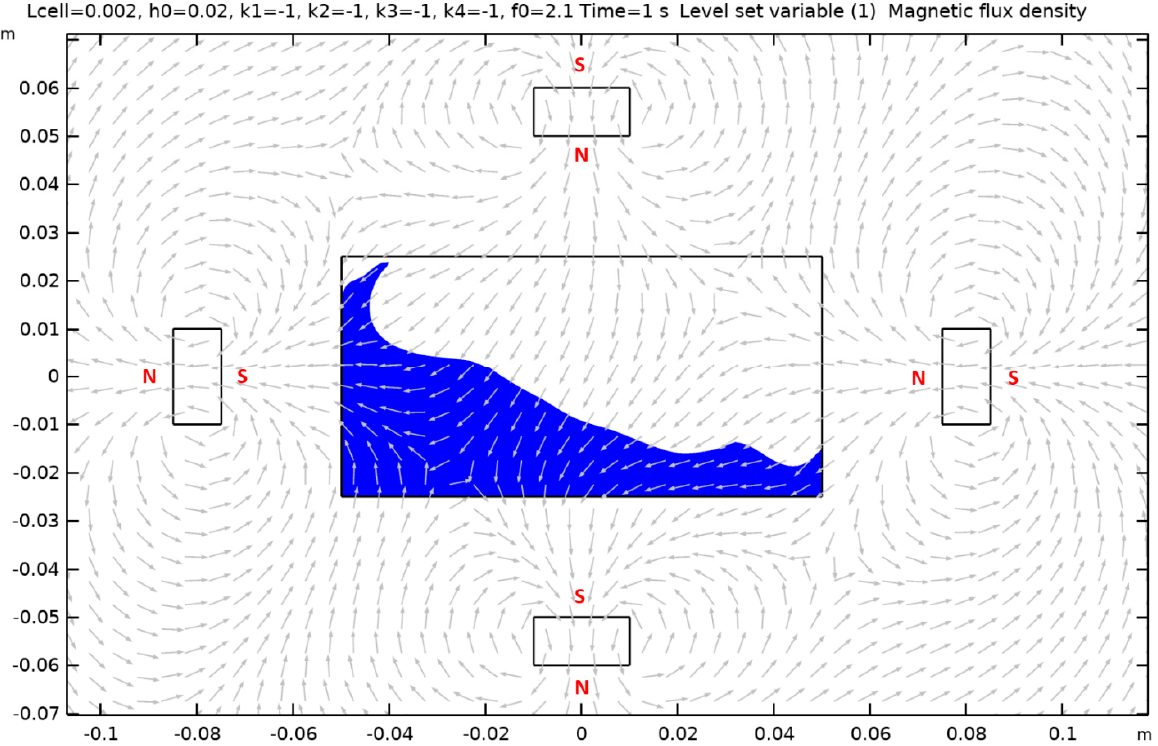
Figure 9. Impedance matching for Vertical coil of 1000 turns on L = 10 cm tank for frequency = 2.05 Hz.